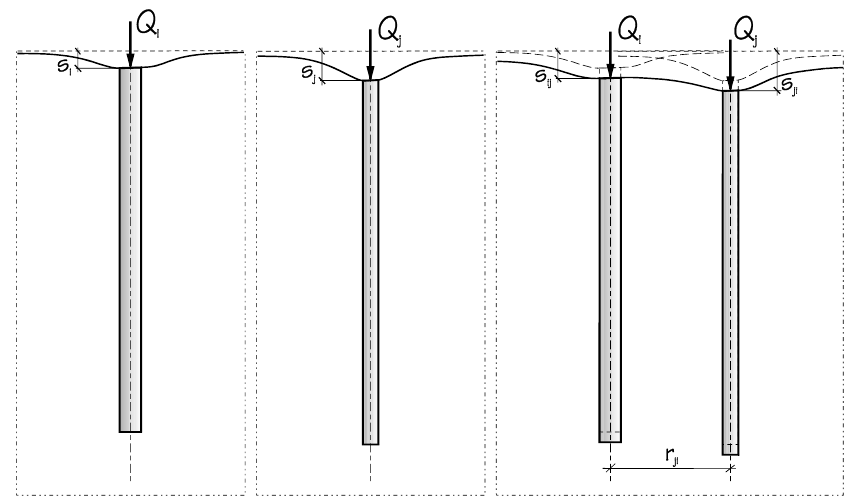
Figure 4. Settlement patterns of pile pair i and j .